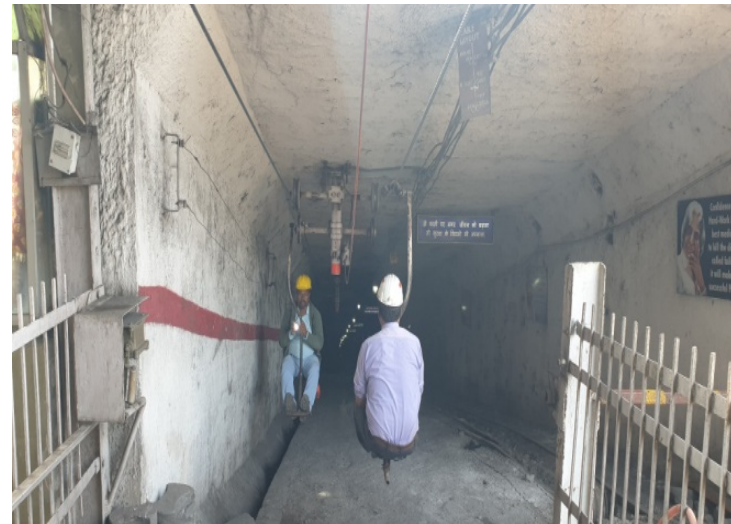
Figure 2. Basic arrangement of MRCL. Table 1. Specification of MRCL.